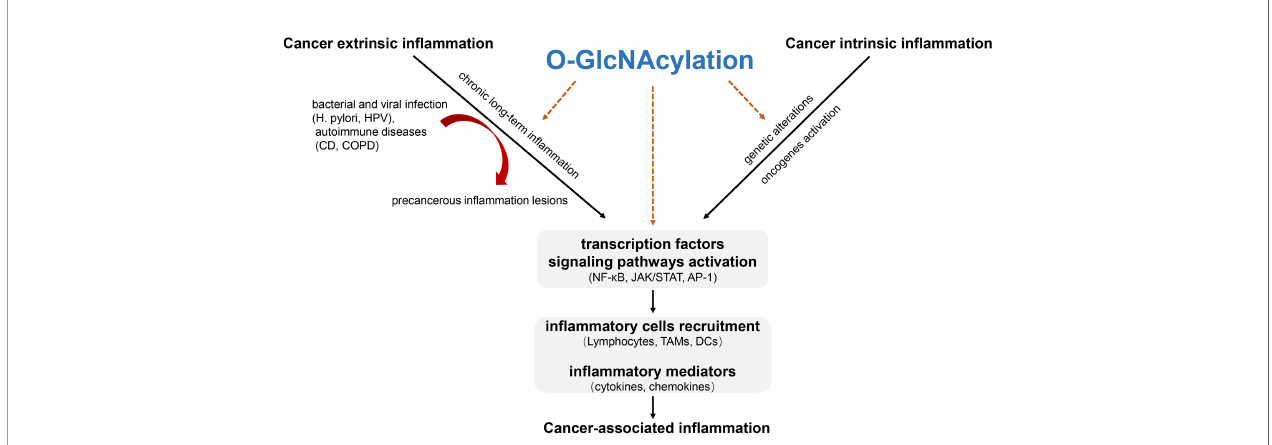
FIGURE 2 | The role of O-GlcNAcylation involved in cancer-associated in fl ammation. Cancer-associated in fl ammation can fall into cancer extrinsic in fl ammation and cancer intrinsic in fl ammation. Cancer extrinsic in fl ammation is driven by long-lasting chronic in fl ammation to form precancerous in fl ammation lesions while cancer intrinsic in fl ammation is elicited by genetic and/or epigenetic mutation to form an in fl ammatory milieu. The two ways converge to promote transcription factors- mediated signaling pathways activation, thus facilitating in fl ammatory cells recruitment and in fl ammatory mediators ’ production. O-GlcNAcylation promotes precancerous in fl ammation and acts as a key orchestrator at the intersection of the intrinsic and extrinsic in fl ammation through O-GlcNAcylating key transcription factors and functional proteins in in fl ammatory cells activation to trigger cancer-associated in fl ammation in tumor microenvironment. H. pylori, Helicobacter pylori; HPV, Human papillomavirus; CD, Crohn ’ s disease; COPD, Chronic obstructive pulmonary disease; TAMs, Tumor associated macrophages; DCs, Dendritic